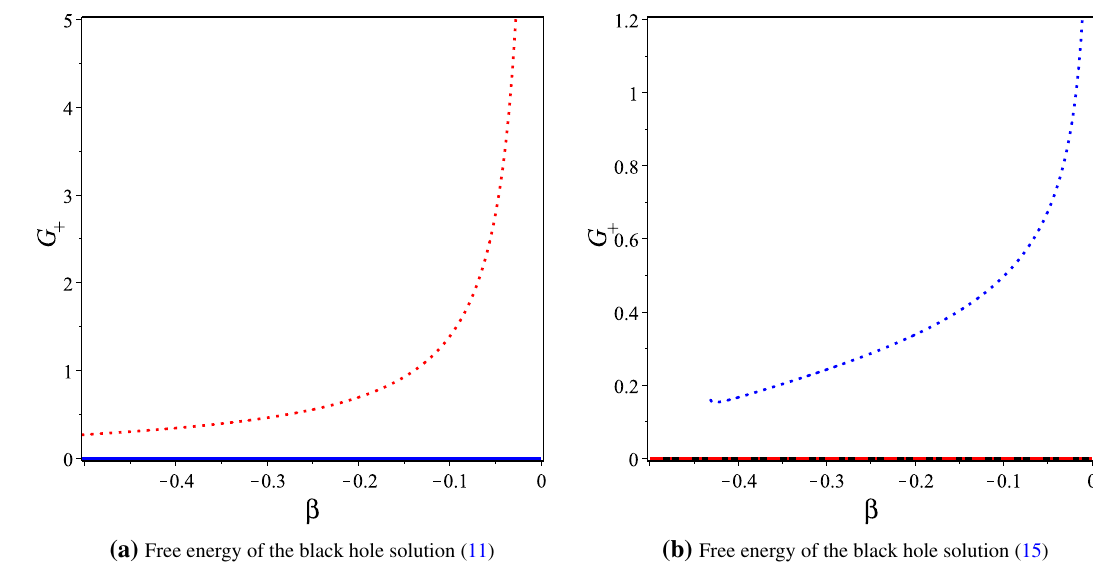
( a ) Free energy of the black hole solution (11) (b) Free energy of the black hole solution (15) Fig. 7 Schematic plot of the free energy of the black holes (11) and (15) versus the dimensional parameter β